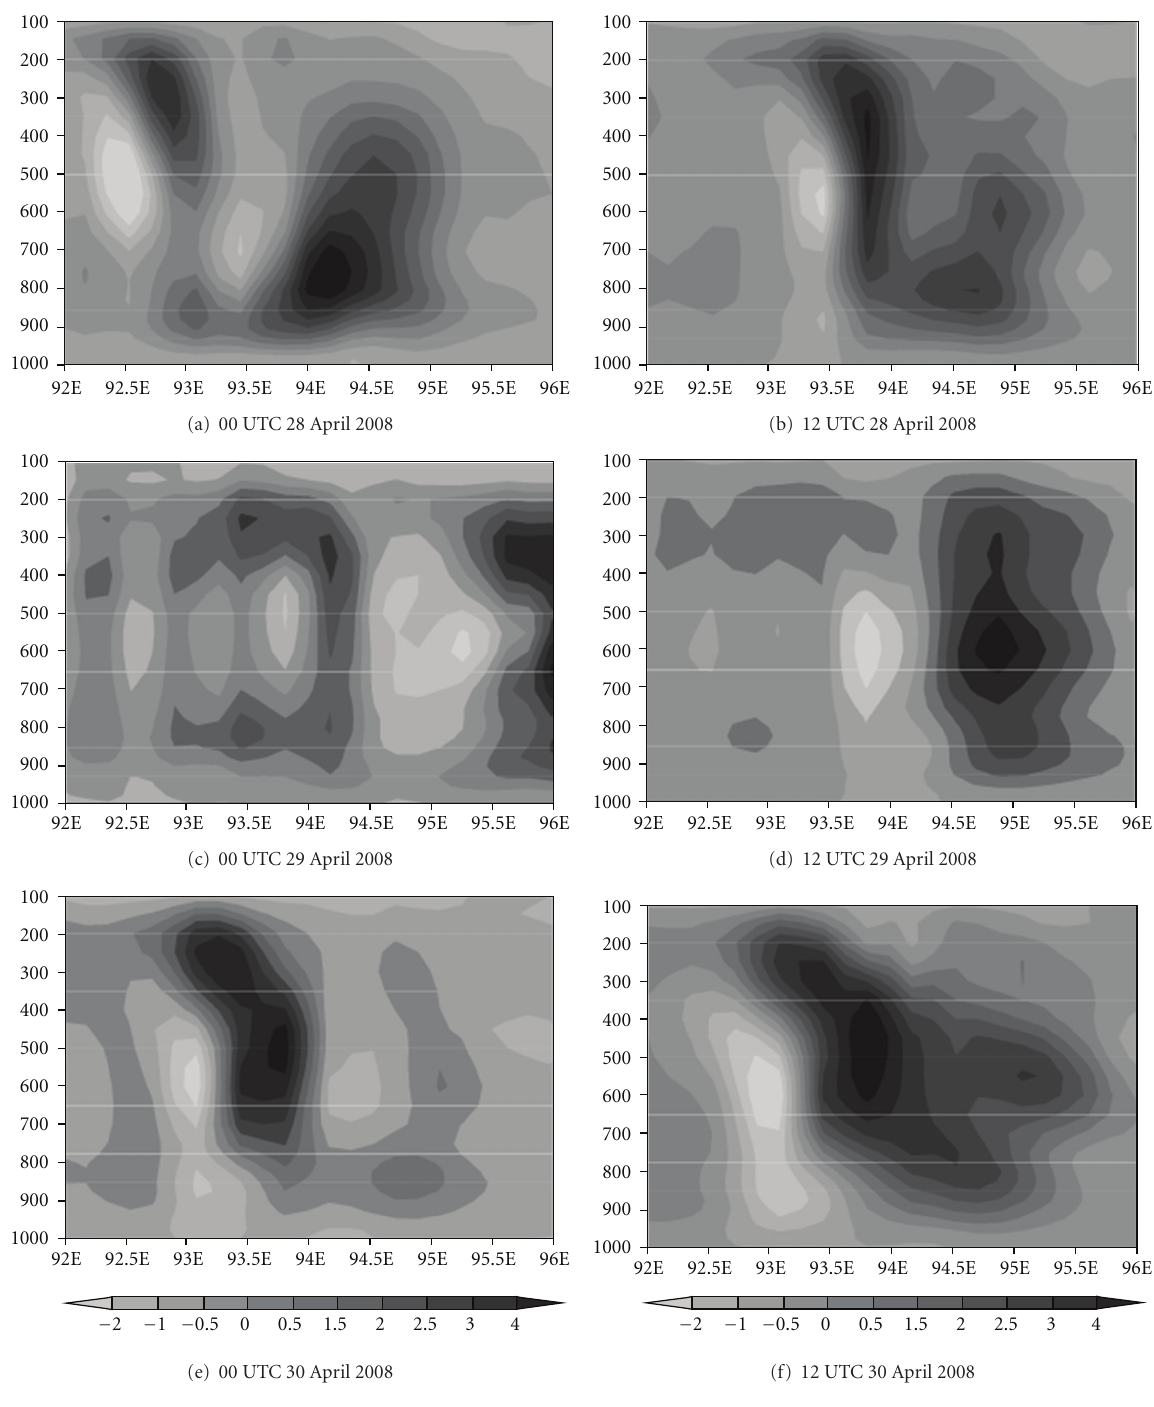
Figure 11: Model-simulated vertical velocity (ms − 1 ) at the peak intense time with di ff erent initial conditions with NMM land surface